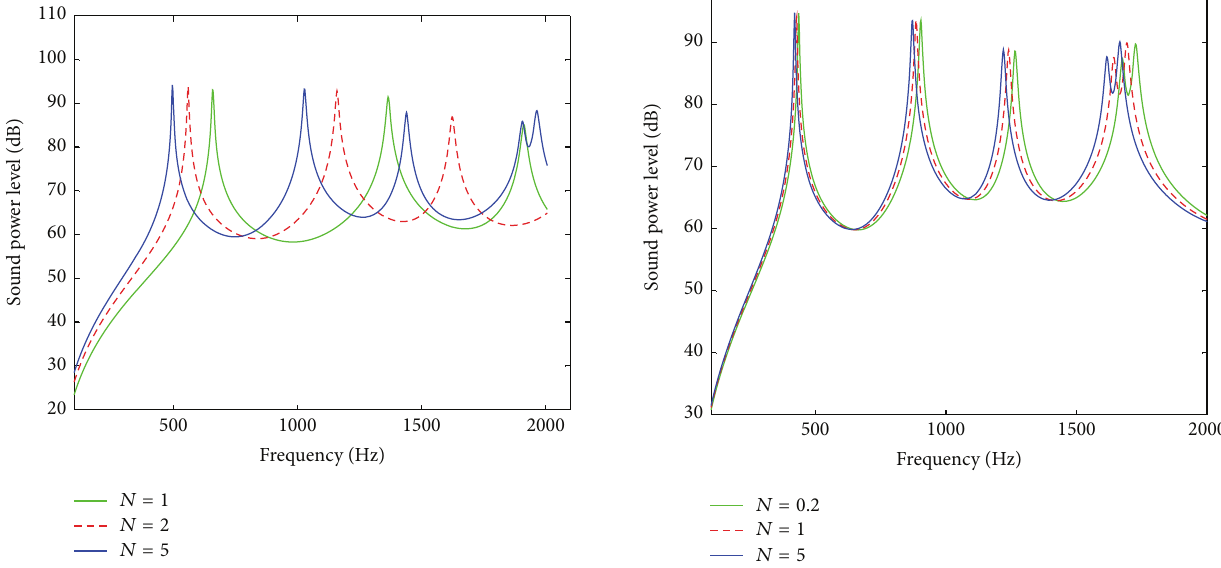
Figure 10: The effect of graded Poisson’s ratio through thickness on sound radiation of FGM